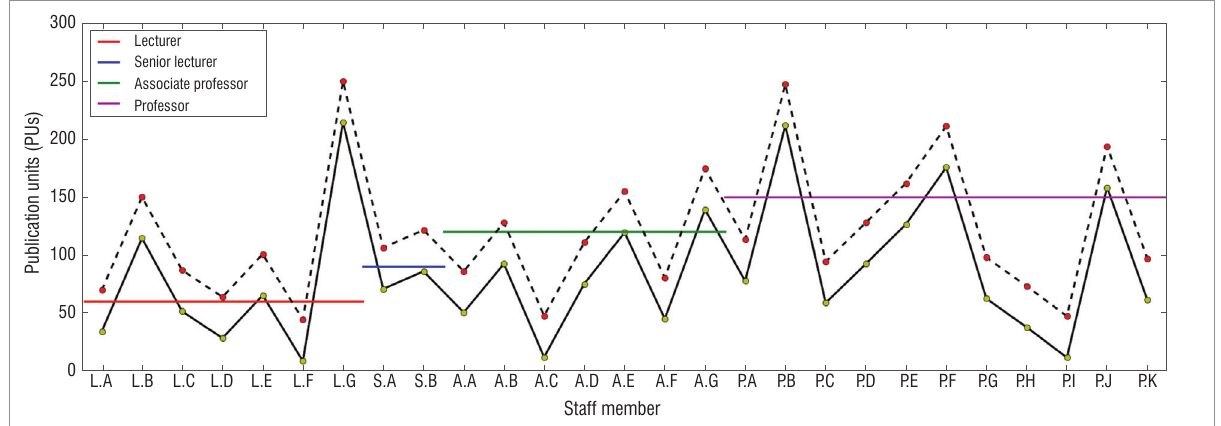
Figure 1: Publication units for permanent academic staff in the Extragalactic and Cosmology Group at Durham University for 2013. Data were extracted from the NASA Astrophysics Data System 8,9 and only publications on the Web of Science list were considered (solid black line). Lecturers, Senior Lecturers, Associate Professors and Professors are labelled L, S, A, P, respectively. Thus ‘S.B’ refers to ‘Senior Lecturer B’. The horizontal coloured lines indicate the expected research productivity level based on academic rank at the University of KwaZulu-Natal in 2014 (Table 1); more than two thirds of staff in the Durham group do not meet these targets based on publications alone. The dashed line shows an optimistic projection for how the output of each academic would be boosted by graduating PhD students. Even after this projection is applied, 44% of the Durham staff would not meet these